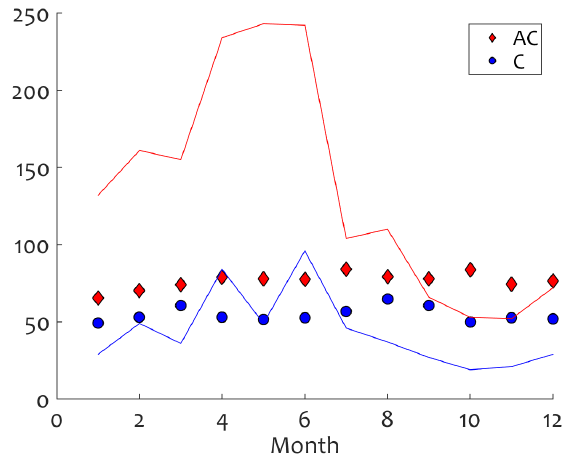
Figure 8. Monthly averaged eddy diameter and number of manifestations for AC (red markers and line) and C (blue markers and line) eddies found in 2008 and 2014 in the Western Mediterranean